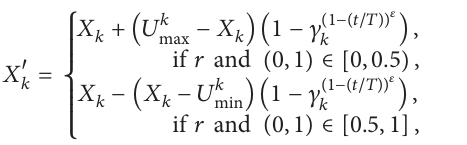
ranks and each individual has a rank 𝑟 𝑝 . In other words, each of these ranks is a set consisting of several